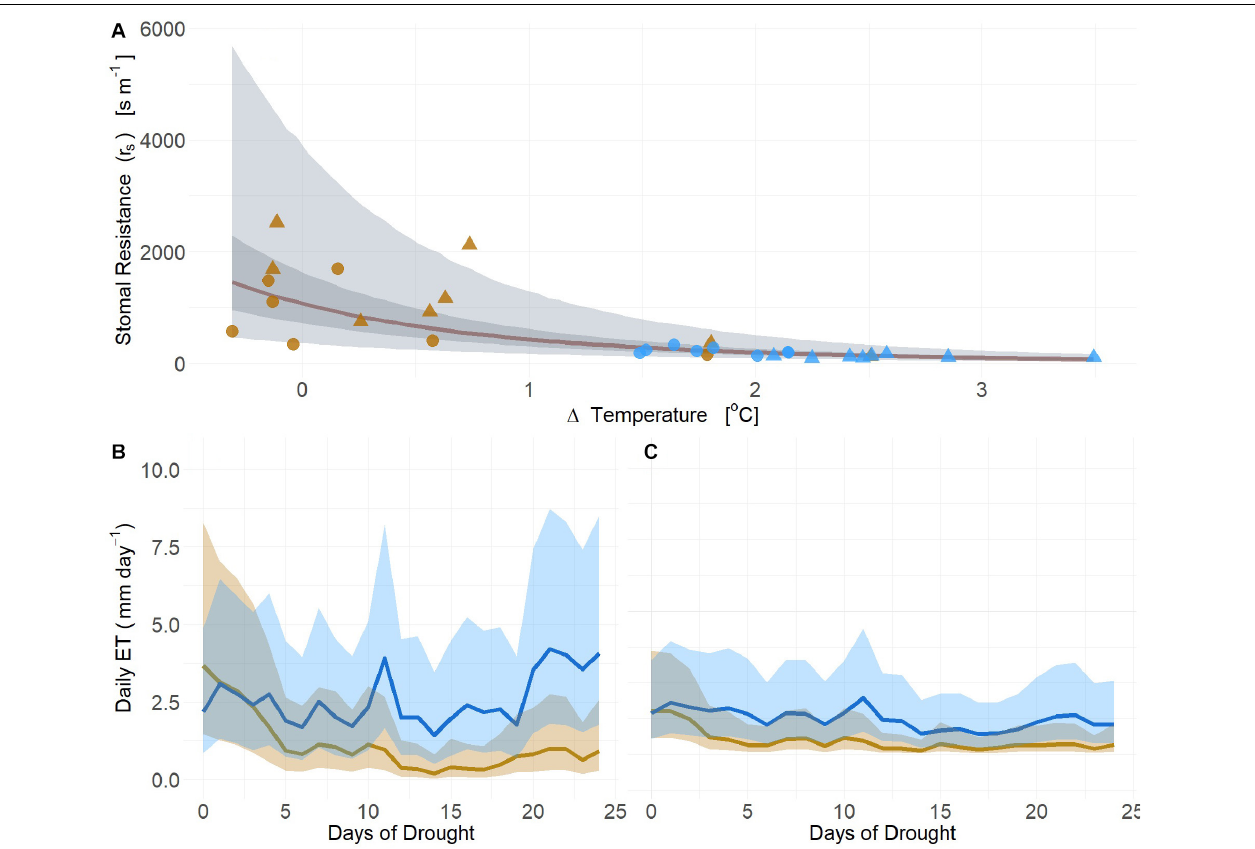
FIGURE 7 | Changes in leaf temperature ( deltaT , air minus leaf temperature) serve as a strong predictor of stomatal resistance ( r s ) (A) across soil moisture gradients from both well-watered (blue) and droughted (gold) POTR (triangle) and PIPO (circle). The r s responses to leaf temperature maximum likelihood estimate (MLE, red), 50% (dark gray), and 94% (light gray) creditable intervals. Integration of r s estimates into process-based models (i.e., Penman-Monteith) capture plant water status and daily ET estimates for POTR (B) and PIPO (C) . The 94% creditable intervals of r s correspond to the uncertainty of daily ET